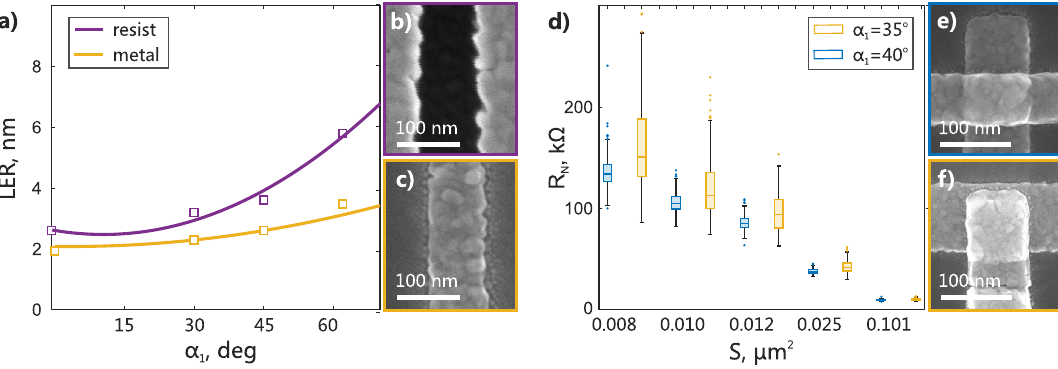
Figure 3. ( a ) Line edge roughness of resist mask after evaporation (purple) and bottom electrode (yellow) as a function of deposition angle ( b ) SEM image of resist mask after evaporation at α 1 = 62°. ( c ) SEM image of measured bottom electrode evaporated at α 1 = 62°. ( d ) Measured normal resistances grouped by nominal junction area. Blue color corresponds to junctions evaporated at 40° angle with electrodes fully overlayed. Yellow-junctions evaporated at 35° with incomplete electrodes overlay. ( e,f ) SEM images of 0.01 μm 2 junctions used in the experiment with and without full overlay respectively.